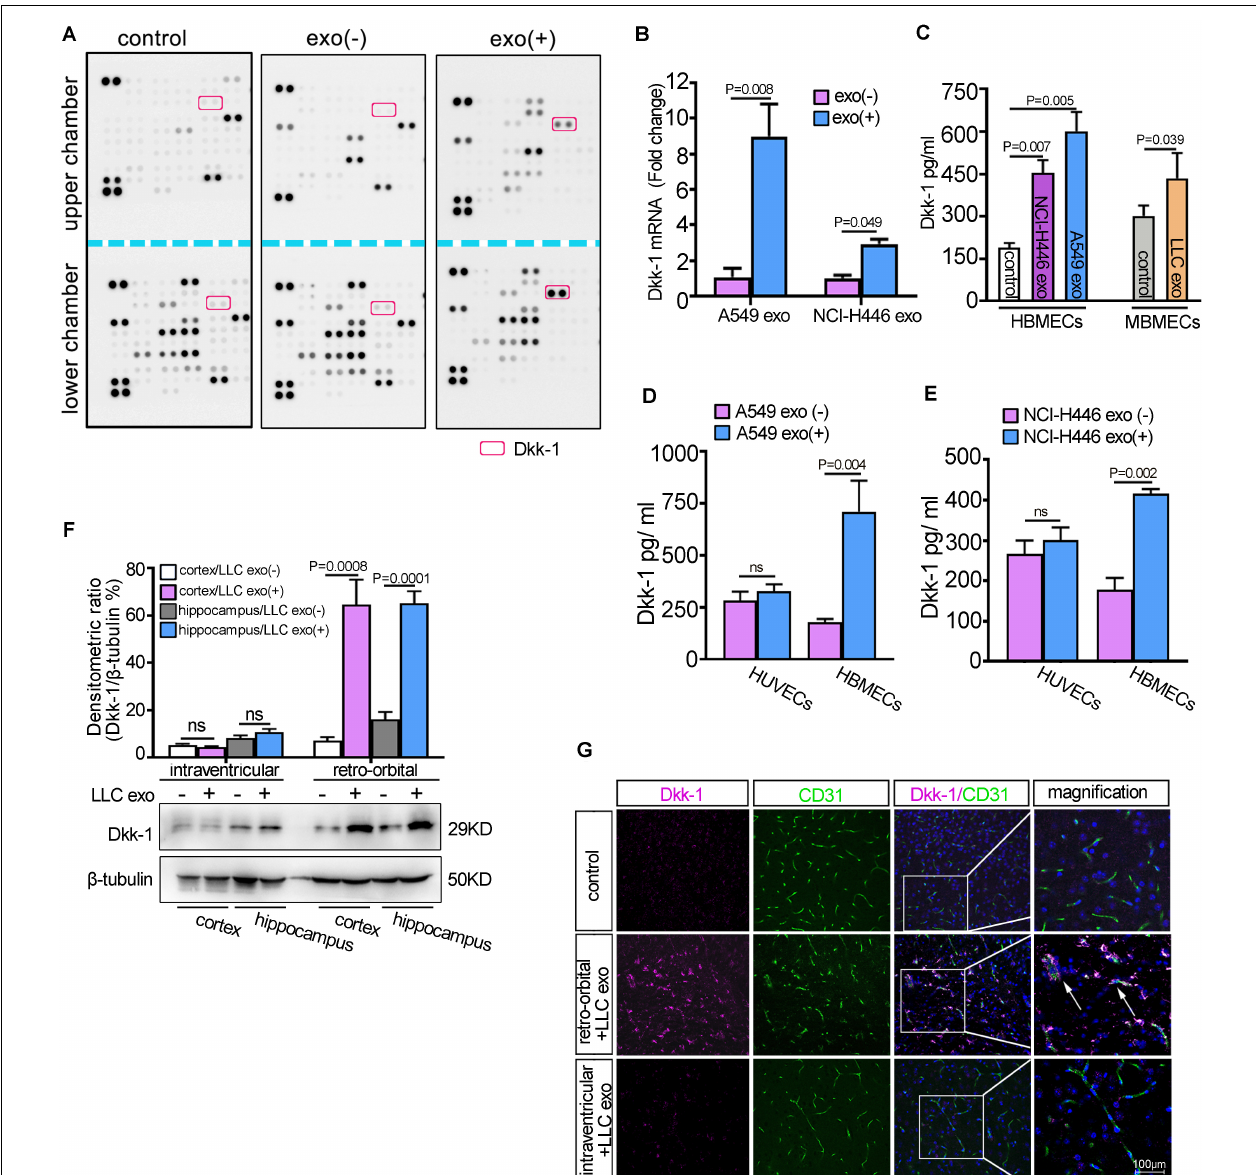
FIGURE 2 | Lung cancer cells-derived exosomes induced brain endothelial cells to secret Dkk-1. (A) HBMECs were cultured on the membrane of Transwells in the presence or absence of A549 cells-derived exosomes and the media were collected from the upper and lower chambers, respectively. A comparative analysis of cytokine secretion was measured by Proteome Profiler Human XL Cytokine Array. (B) The qRT-PCR analysis of Dkk-1 in HBMECs incubated with lung cancer cells-derived exosomes. The results were presented as mean ± SD of three independent experiments. (C) ELISA analysis for the levels of Dkk-1 secreted by the brain endothelial cells after treatment with the indicated lung cancer cells-derived exosomes. The untreated groups were as the controls. The results were presented as mean ± SD of three independent experiments. (D) A comparative analysis of Dkk-1 secretion between HBMECs and HUVECs after treatment with A549 cells-derived exosomes. The results were presented as mean ± SD of three independent experiments. (E) A comparative analysis of Dkk-1 secretion between HBMECs and HUVECs after treatment with NCI-H446 cells-derived exosomes. The results were presented as mean ± SD of three independent experiments. (F) The analysis of western blots for Dkk-1 in the cerebral cortex and hippocampus regions of mice after LLC cells-derived exosomes administration by retro-orbital and intra-ventricular injection, respectively. Above: The histograms represented the average levels of Dkk-1 measured by densitometric values, normalized to the levels of β -tubulin. The results were presented as mean ± SD of three independent experiments. Below: The representative image of western blots for Dkk-1 expression was shown. (G) The immunofluorescence staining for the distribution of Dkk-1 in the mice brain after LLC cells-derived exosomes administration by retro-orbital and intra-ventricular injection, respectively. The inset box to right at a higher magnification. Arrows ( ↑ ) indicated the location of Dkk-1 in the brain endothelial cells. Scale bar, 100 µ m.